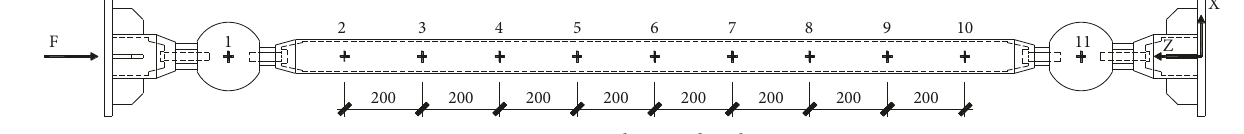
Figure 9: Control point distribution. Table 3: Loading systems for